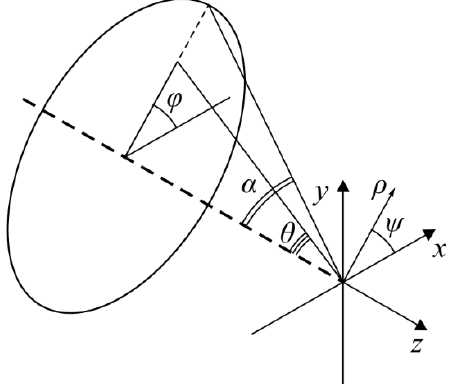
Figure 1. The geometric interpretation of the problem.